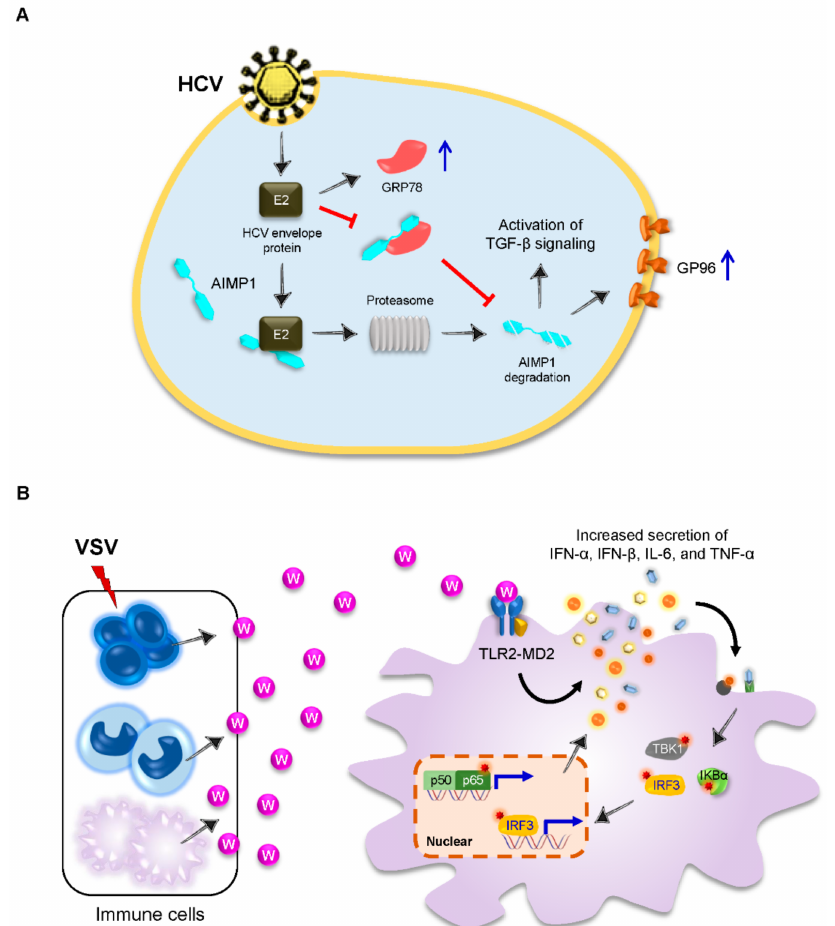
Figure 2. AIMP1 and TrpRS in viral infection. ( A ) Upon HCV infection, HCV envelope protein E2 directly interacts with AIMP1 and induces a ubiquitin-dependent proteasomal degradation of AIMP1. On the other hand, HCV E2 leads to the upregulation of GRP78 (blue arrow) but inhibits the interaction between AIMP1 and its stabilizer GRP78, resulting in AIMP1 degradation. The degradation of